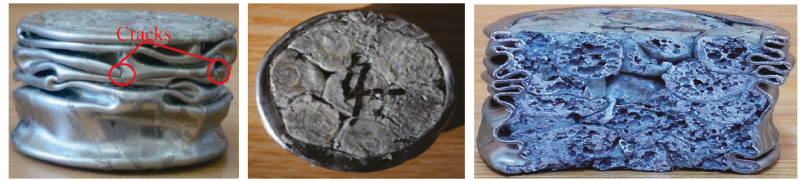
Figure 6: Final morphology of epoxy-bonding APM composite pipes after compression.